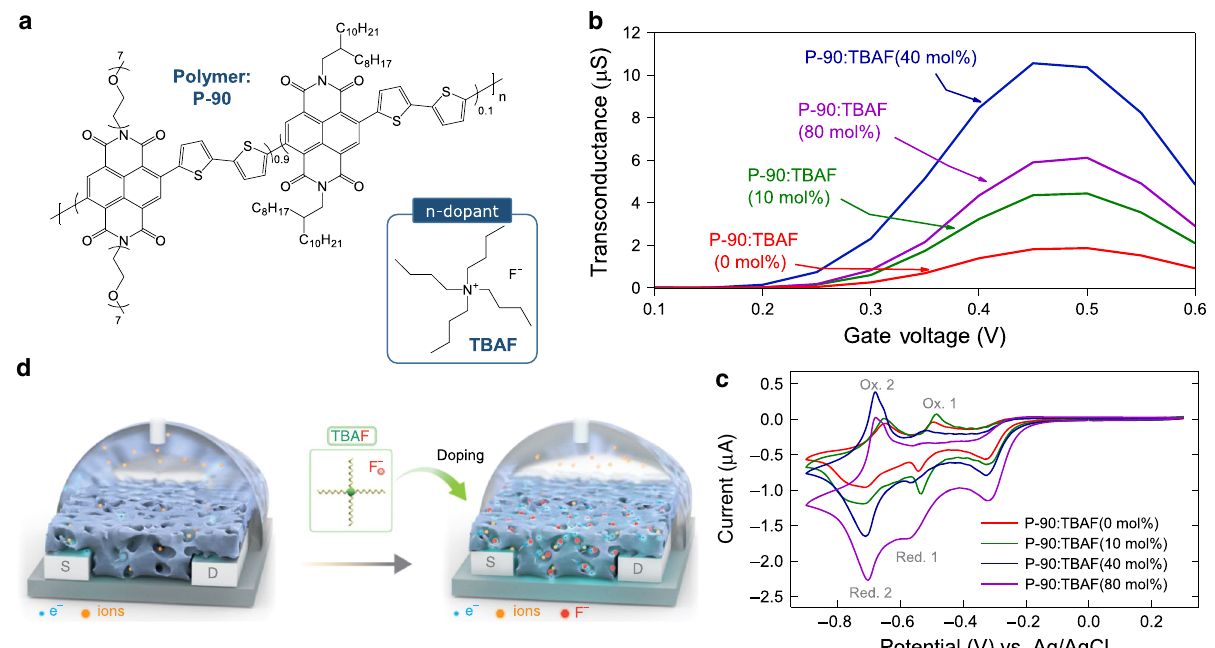
Fig. 1 Doped electron transporting organic electrochemical transistors. a Materials used throughout this work: a copolymer made from naphthalene- 1,4,5,8-tetracarboxylic diimide (NDI) and bithiophene (T2) with ethylene glycol or alkyl side chains attached to the NDI unit the comonomer, named P-90; the Lewis basic ammonium salt tetra-n-butylammonium fl uoride (TBAF) used as an n-dopant. b Transconductance of best-performing P-90 organic electrochemical transistors containing 0, 10, 40 and 80 molar percentage (mol%) TBAF. g m_max is taken at V G ≈ 0.5 V and V D ≈ 0.6 V, all transistors have a channel length and width of 10 µ m and 100 µ m, respectively, and channel thicknesses are given in Table 1. c Cyclic voltammetry measurements for P-90 thin- fi lms containing 0, 10, 40 and 80 mol% TBAF, measured at a scan rate of 0.05 V/s, with labelled redox peaks. Film thicknesses are given in Table 1. d Organic electrochemical transistor con fi guration and graphical illustration representing TBAF doping mechanisms in P-90, which increase electron density and subsequent ion uptake.